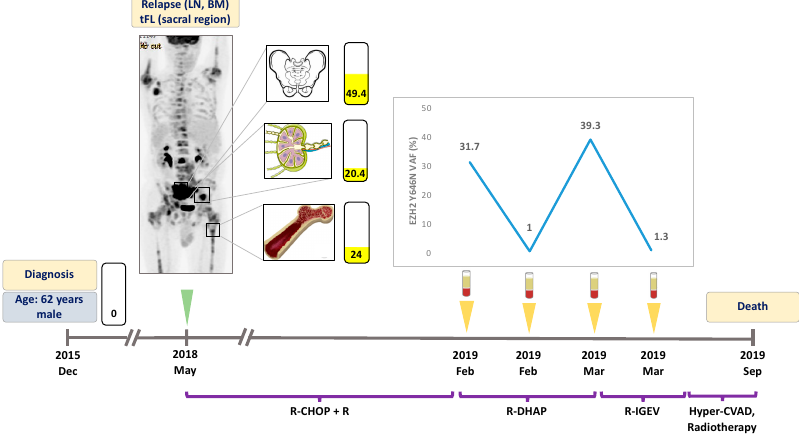
Figure 2. Detailed illustration of treatment monitoring in Patient #2. EZH2 Y646N mutation was found in three sites at relapse. ctDNA EZH2 Y646N allele frequencies fluctuated in parallel with treatment efficacy and refractoriness. Failure to eliminate EZH2 mutations from the plasma indicated poor prognosis. Numbers in the rectangles represent the VAF of the mutation, yellow color indicates the Y646N variant. Green arrow indicates the time when the PET scans were performed, yellow arrows indicate the time when liquid biopsy specimens were collected. LN: lymph node, BM: bone marrow, tFL: transformed follicular lymphoma. VAF: variant allele frequency. R-CHOP: rituximab, cyclophosphamide, doxorubicin, vincristine, prednisone. R-DHAP: rituximab, dexamethasone, high-dose cytarabine, cisplatin. R-IGEV: rituximab, ifosfamide, gemcitabine, vinorelbine. Hyper-CVAD: Course A: cyclophosphamide, vincristine, doxorubicin, dexamethasone. Course B: methotrexate,